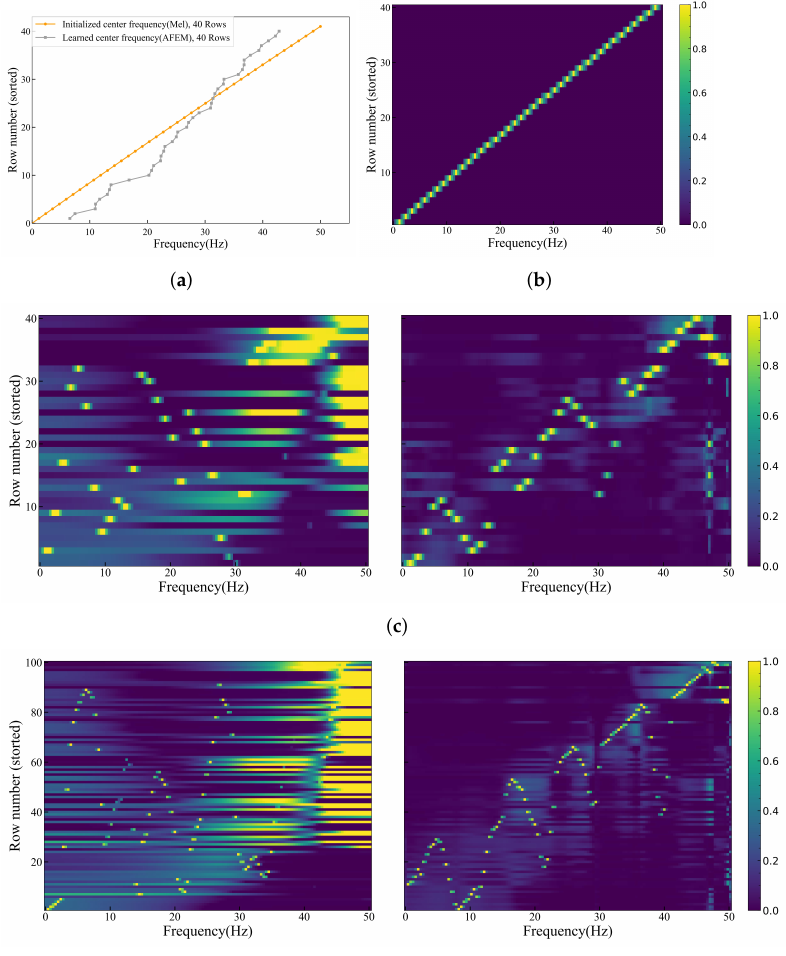
Figure 13. Magnitude response of the learned weight matrix ordered in centre frequency. ( a ) Mel initialization and learned centre frequency (AFEM); ( b ) Mel-initialized weight matrix (AFEM) linear layer; ( c ) Training weight matrix of 40 dimensions with ( right ) and without ( left ) normalization; ( d ) Training weight matrix of 100 dimensions with ( right ) and without ( left )